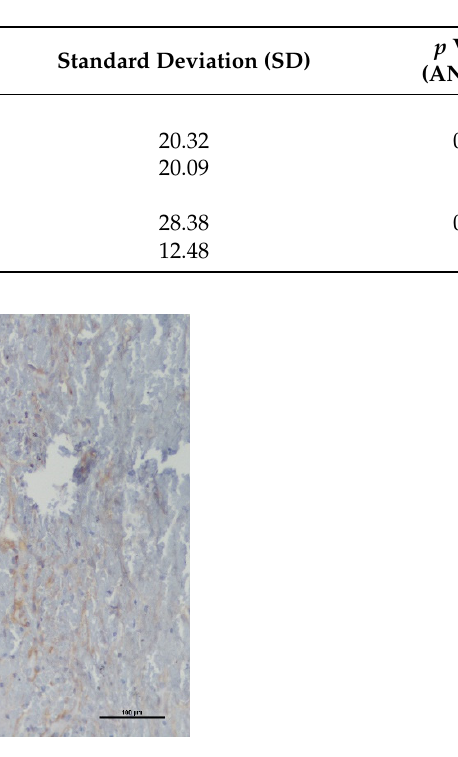
Figure 2. Immunohistochemical staining of PDGFR- β in canine cutaneous MPNST (×100). Tumor invasive front showing high levels of PDGFR- β expression. Table 4. Relationship between PDGFR- β expression and clinicopathological variables in 19 canine PNST.